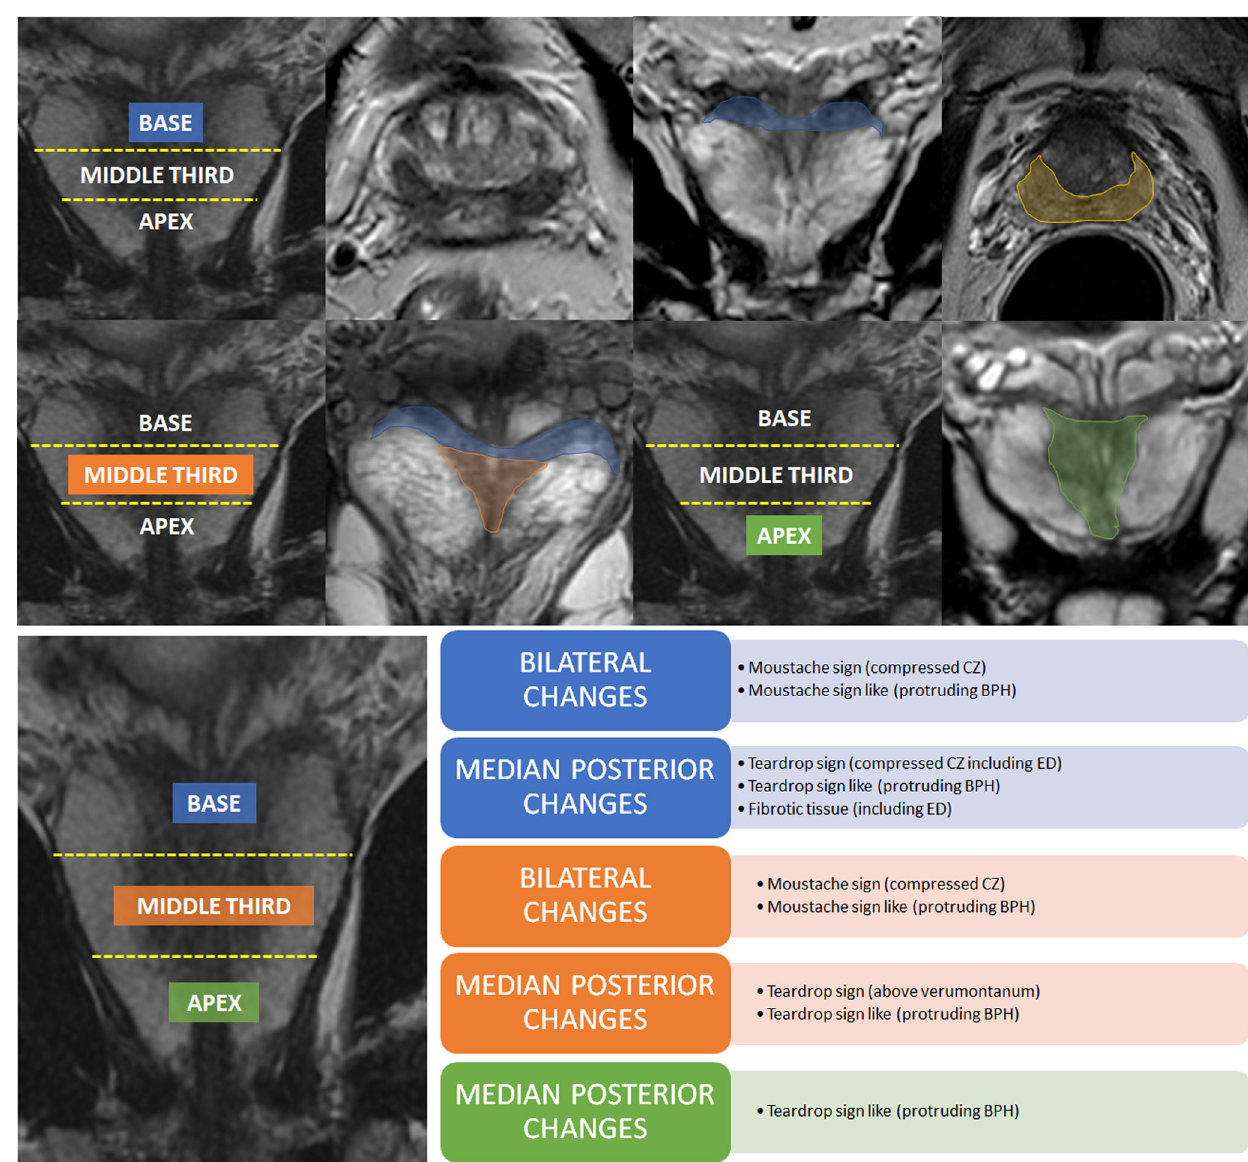
Fig. 8 Summary of the different signs ( moustache or teardrop ) at different levels. CZ = central zone; BPH: benign prostatic hyperplasia; ED = ejaculatory